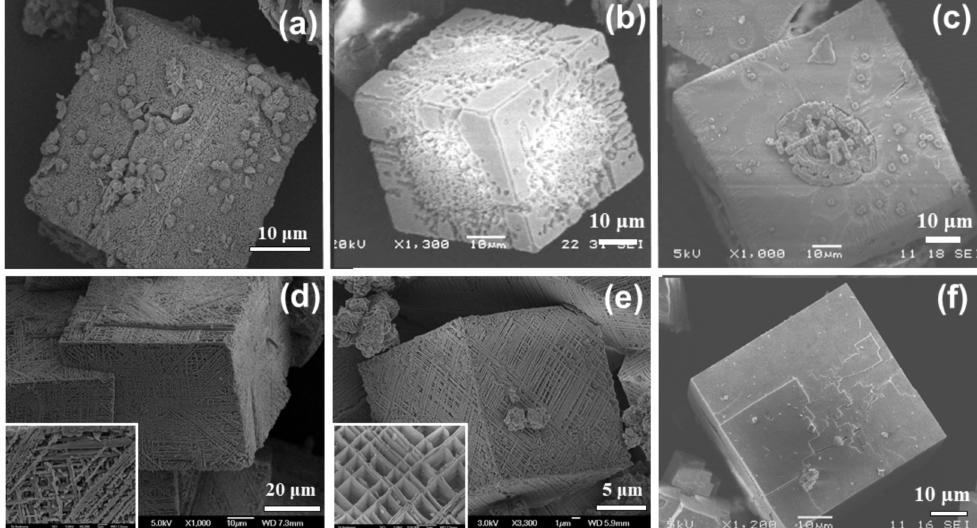
Figure 2. SEM images of metal organic framework (MOF-5) particles. ( a ) An individual polycrystalline cubic particle with a rough surface. ( b ) A cube when the surface partially re-crystallized. ( c ) A cube with a single crystal shell nearly completed. ( d ) Typical textured cubes. Inset is an enlarged image. ( e ) A typical MOF-5 cube with a woven surface. Inset is an enlarged image showing a house-of-cards structure. ( f ) A MOF-5 cube with a single crystal shell. ( a – c , f ) Reproduced from [25] with permission from The Royal Society of Chemistry. ( d , e ) Reprinted with permission from [26]. Copyright 2016, American Chemical